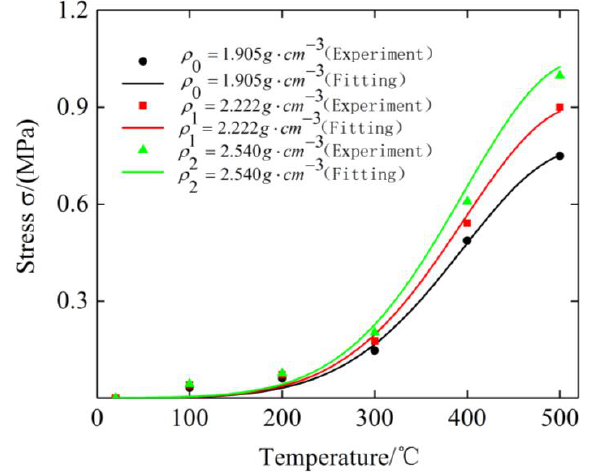
Figure 16. Stress–strain curves of three specimens at di ff erent temperatures and their fitting Figure 16. Stress – strain curves of three specimens at different temperatures and their fitting curves.